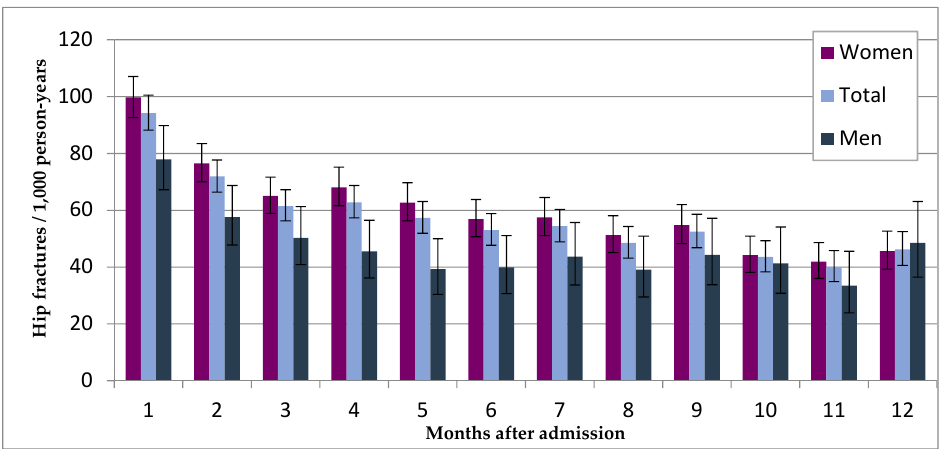
Figure 1. Incidence rates of hip fractures stratified by the period after nursing home admission with 95% CI, by sex.